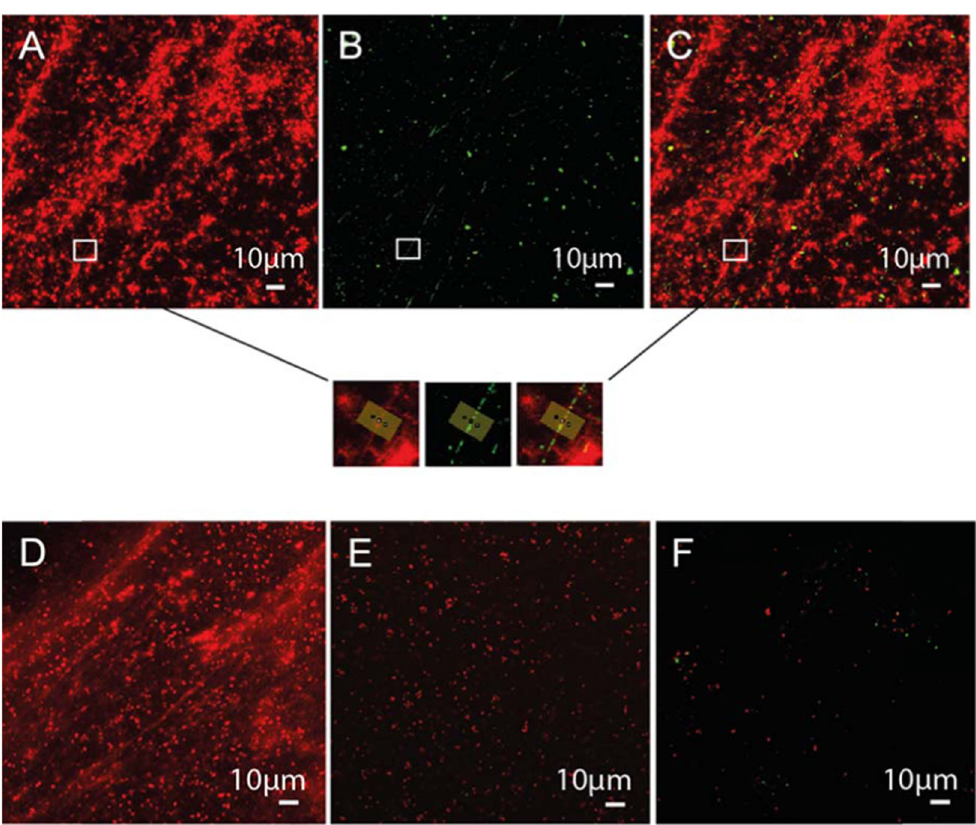
Fig. 5 G-quadruplex DNA observed in P. aeruginosa bio fi lms and its loss coincides with the disappearance of matrix fi bres. Confocal micrographs of 3-day P. aeruginosa rugose small colony variant (RSCV) pellicle bio fi lm showing the presence of eDNA fi bres, visualised by binding to DNA-speci fi c dye propidium iodide (PI; red) ( A ), the binding of anti-DNA G-quadruplex structure antibody to the eDNA fi bres, visualised with GFP-labelled goat anti-mouse IgG (green) ( B ) and overlapping bindings of both PI and anti-DNA G-quadruplex antibody ( C ). The zoomed-in insets from the three images show that the anti-DNA G-quadruplex antibody binds to eDNA fi bres. The horizontal line denotes the region used to describe the colocalisation of PI and G-quadruplex antibodies in terms of channel pixel intensity as a function of location, where PI and G-quadruplex colocalise at the sixth pixel of the line (Supplementary Figure 9). Confocal micrograph of the RSCV pellicle bio fi lm with pre-heating to 60 °C ( D ) and pre-heating to 70 °C ( E ), with PI and anti-DNA G-quadruplex antibody with GFP-labelled goat anti-mouse IgG (green) overlapping, showing almost complete disappearance of G-quadruplex structures by 60 °C, and partial and complete disappearance of eDNA fi bres at 60 and 70 °C, respectively. Confocal micrograph of DNase-treated 3-day P. aeruginosa rugose small colony variant pellicle bio fi lm overlapping (PI) and anti-DNA G-quadruplex structures ’ antibody with GFP-labelled goat anti-mouse IgG (green), showing that the eDNA fi bres disappear coincident with the loss of anti-DNA G-quadruplex antibody binding ( F ). Scale bars represent 10